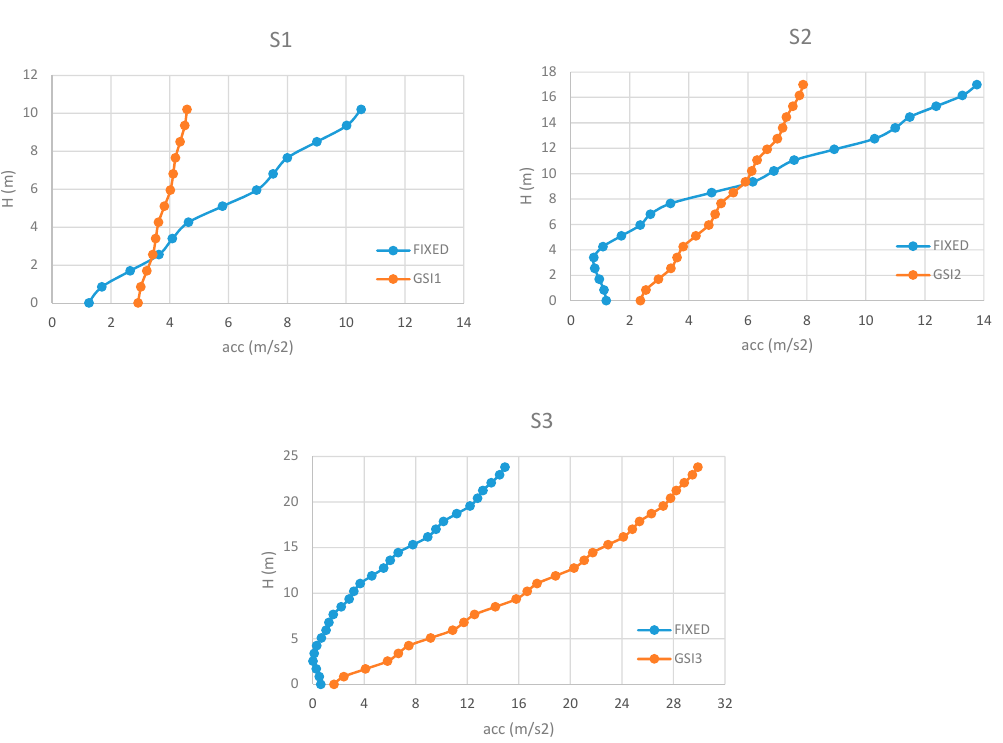
Figure 13. Maximum accelerations along the height (IM5).